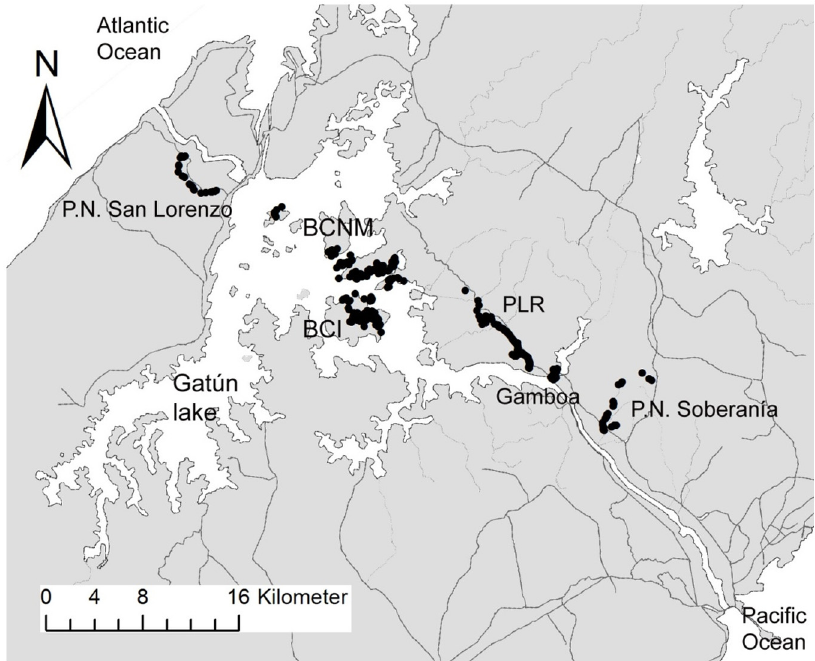
Fig 1. Sampling sites of F . insipida located along the Panama Canal. Black dots indicate sampled individuals. (BCNM: Barro Colorado Nature Monument, BCI: Barro Colorado Island, PLR: Pipeline Road, detailed maps for all species sampled in BCNM are presented in S3